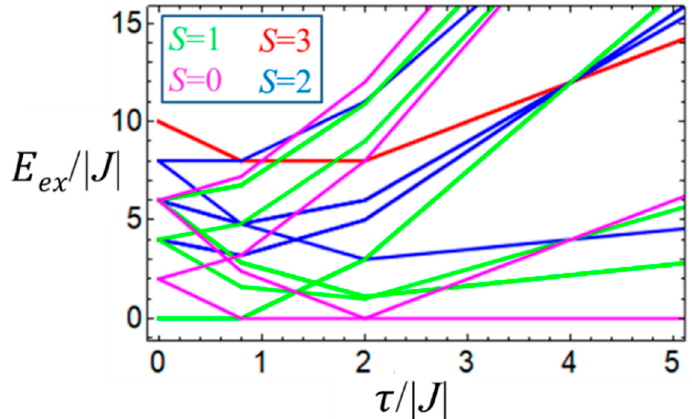
Figure 6. Correlation diagram E ex / | J | vs τ / | J | for the MV square-planar d 2 − d 2 − d 1 − d 1 -tetramer calculated within the strong U -limit. Coloring of spin states is shown in the insert.